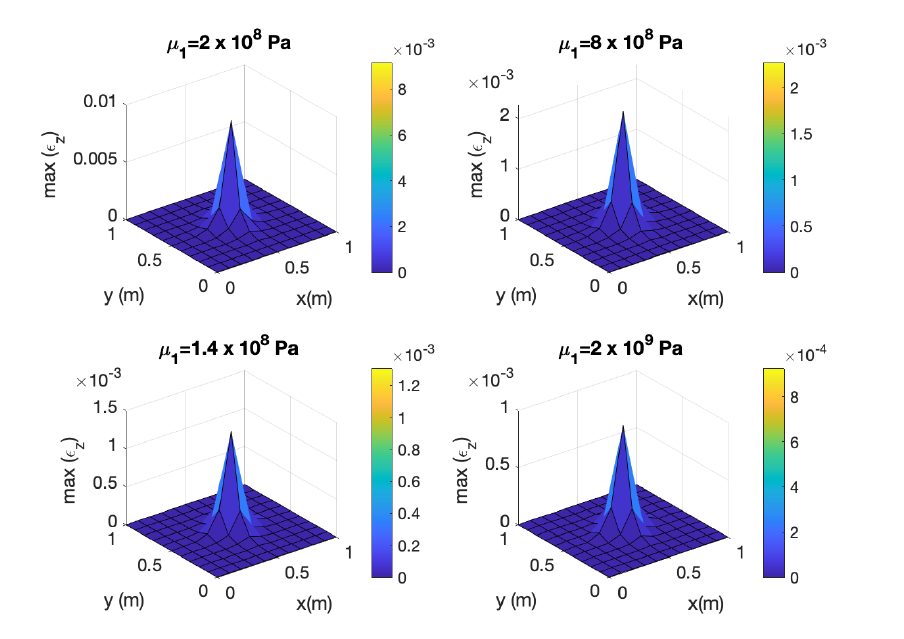
Figure 4. Maximum strain (cid:101) z at the top of the top layer. Because of the significant differences in the strain values, for the sake of clarity, different scales are considered in each figure.